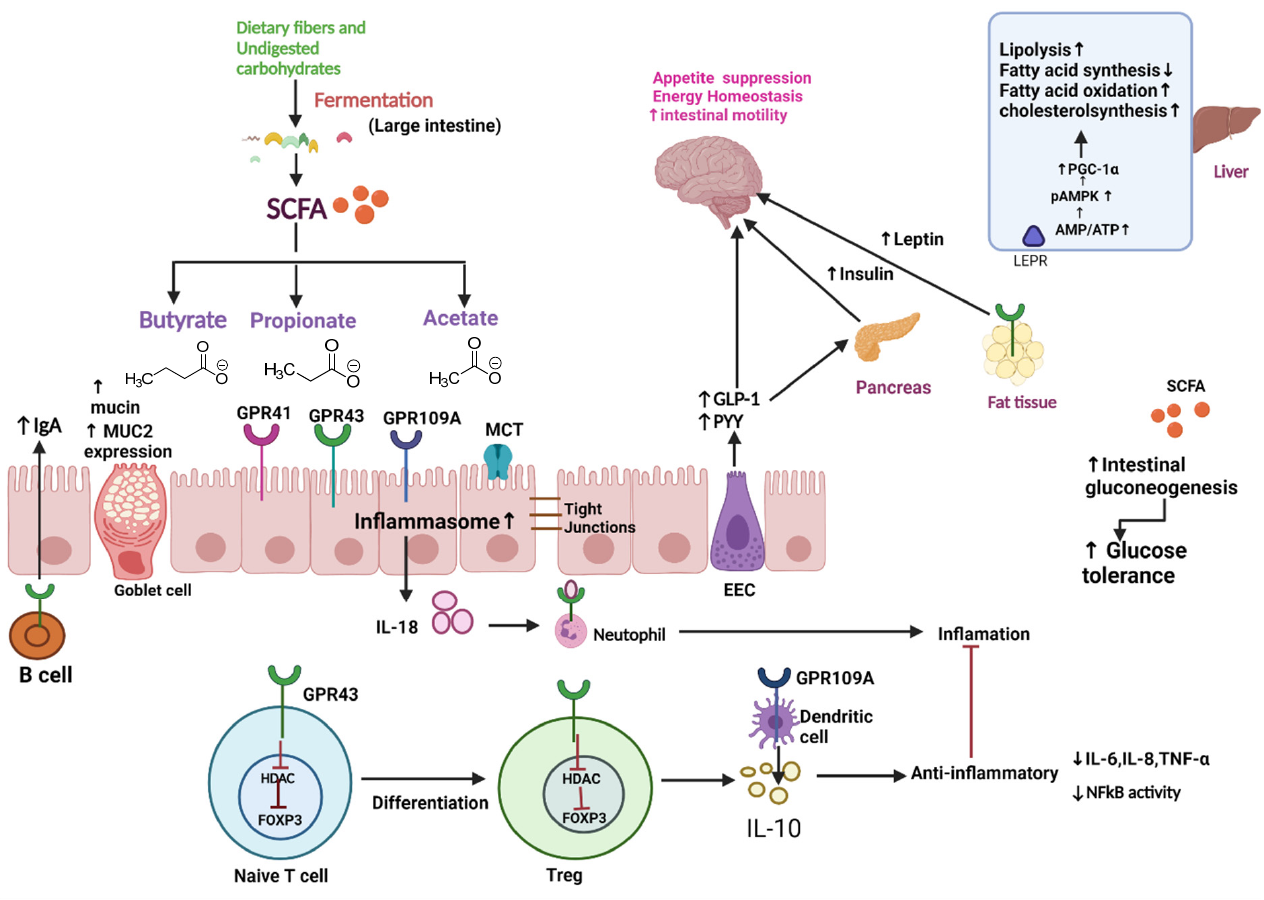
Figure 2. Schematic overview of microbiota and its metabolites —In the large intestine, dietary fiber and undigested carbohydrates are fermented into SCFA (Butyrate, propionate, and acetate) by gut microbiota. These metabolites can regulate tight junction, increase mucin production, upregulate MUC-2 expression, and increase synthesis of IgA through B cell activation. These metabolites also exert an anti-inflammatory effect by inhibiting HDAC (which leads to the differentiation of naïve T cells to regulatory T cells), which further decreases the production of proinflammatory cytokines, such as IL-6, IL-8, TNF- α , and NFkB activity. SCFA also stimulates intestinal gluconeogenesis, improving glucose tolerance. Moreover, SCFA can stimulate EEC to release GLP-1 and PYY, which acts as an anorexigenic agent by suppressing appetite and GLP-1 stimulate the pancreas to release insulin, thus increasing the uptake of glucose in muscle and adipose tissue. SCFA suppresses appetite by increasing leptin synthesis in adipose tissue. In liver SCFA, phosphorylate and activate AMPK directly by increasing the AMP/ATP ratio or indirectly via LEPR. Activation of AMPK triggers PGC-1 α expression, which promotes fatty acid oxidation, lipolysis, and cholesterol synthesis and decreases fatty acid synthesis. Abbreviations: SCFA, Short-Chain Fatty Acid; MUC2, Mucin2; HDAc, Histone acetylation; EEC, Enteroendocrine cell; GLP-1, Glucagon-like Peptide 1; PYY, Peptide YY; pAMPK, phosphorylated Adenosine monophosphate activated protein kinase; AMP, adenosine monophos- phate; ATP, adenosine triphosphate; LEPR, leptin receptor; PGC-1 α peroxisome proliferator-activated receptor gamma coactivator